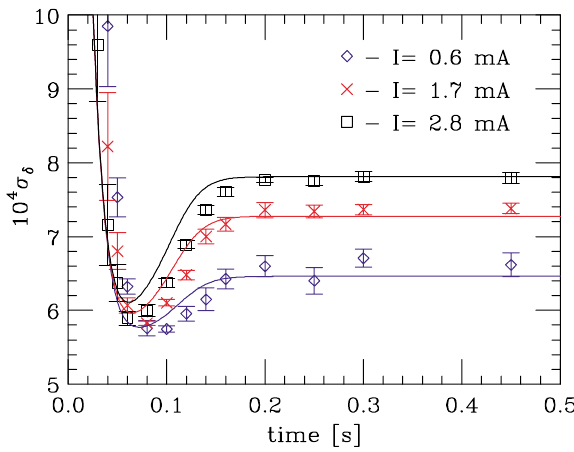
FIG. 4. (Color) Measured energy spread as function of time after injection, for three different currents (the plotting symbols). The curves give BM simulations assuming an x - y coupling of 0.006 and no potential well distortion. This plot is reproduced from Ref. [4].